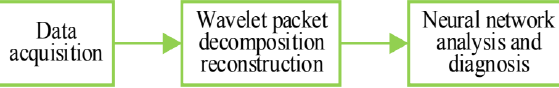
Fig. 2. Schematic diagram of diagnosis scheme